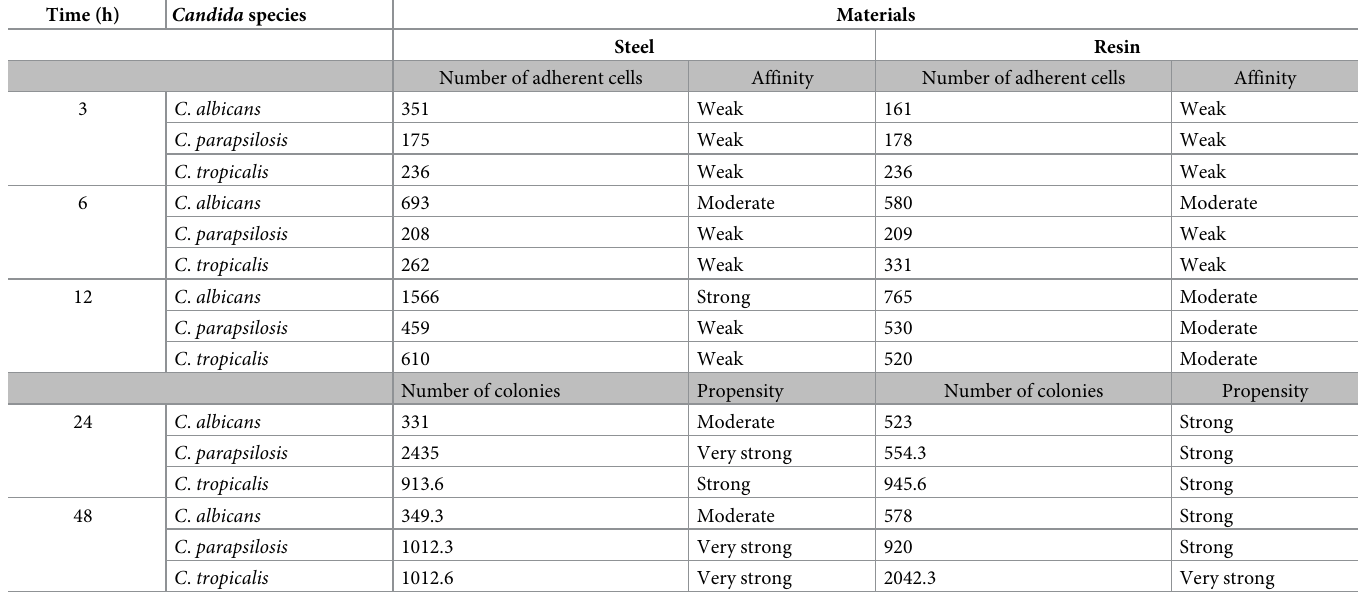
Table 5. Adhesion capacity and biofilm formation propensity of C . albicans , C . parapsilosis , and C . tropicalis on the surfaces of steel and acrylic resin orthodontic materials. Time (h) Candida species